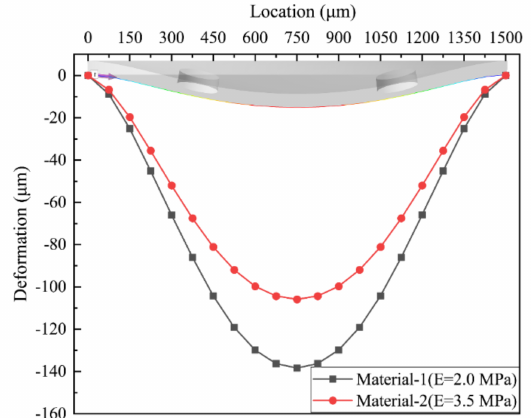
Figure 13. Deformation of the membrane at an inlet pressure of 4